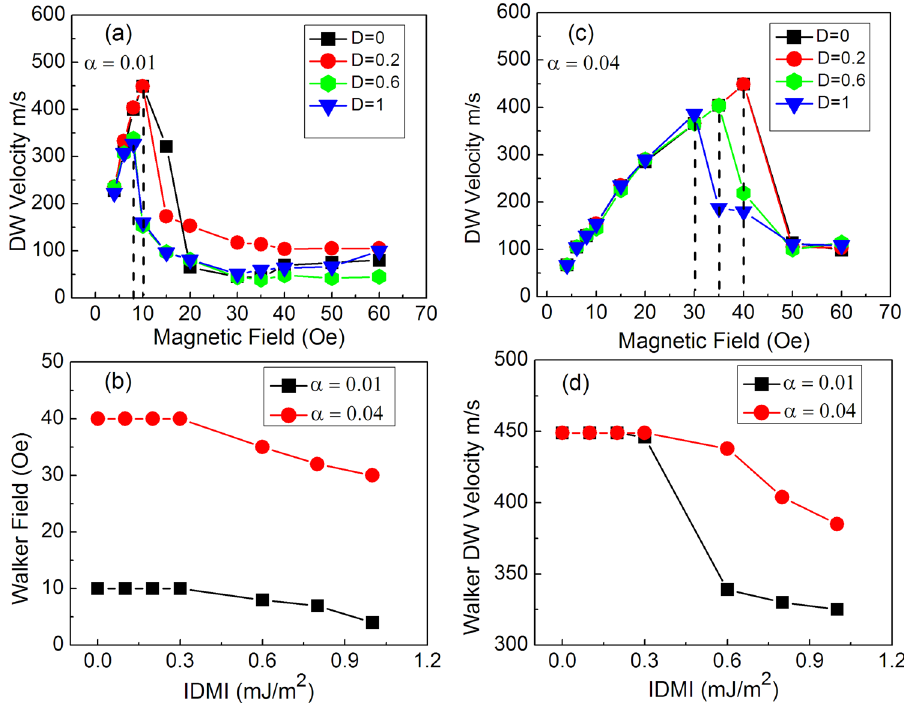
Figure 6. DW velocity calculated in parallel sided nanowires for various IDMI and damping 0.01 ( a ) and 0,04 ( c ). For both the damping values the velocity undergoes a reduction beyond the Walker Field threshold. The Walker Field is higher for damping of 0.04 than 0.01. However, the IDMI affects both the Walker field ( b ) and DW velocity ( d ), which for IDMI beyond 0.3 (mJ/m 2 ) are